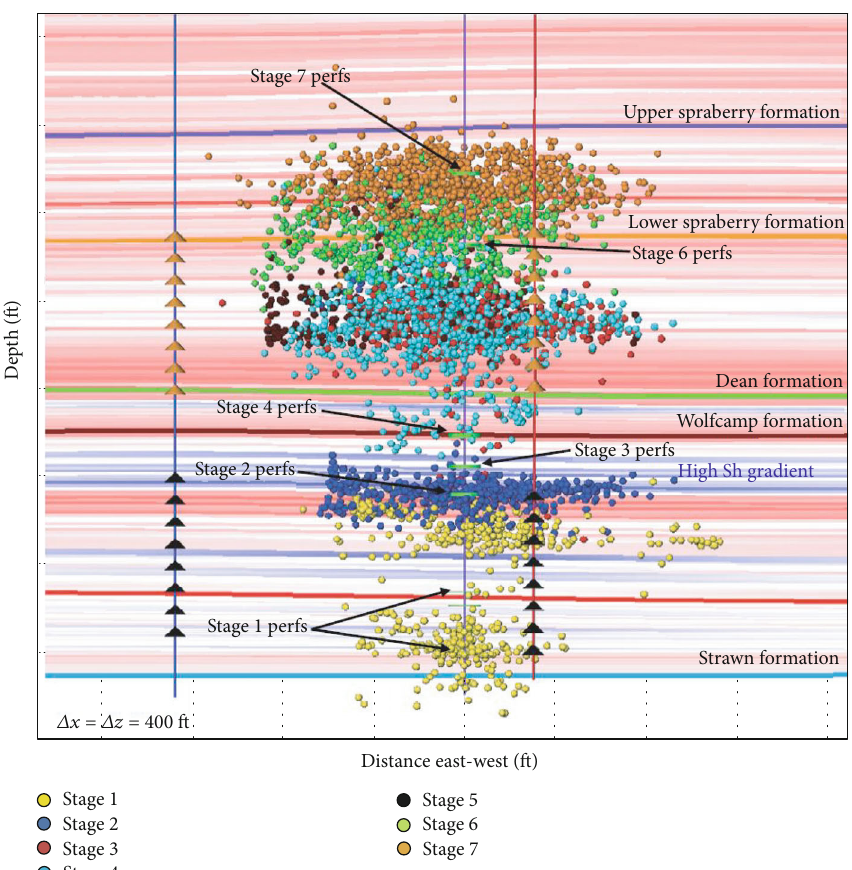
Figure 1: A longitudinal view showing the length and height of the microseismic interpreted hydraulic fractures in di ff erent stages. A cross- section of the minimum horizontal stress gradient is also presented in this fi gure. The dots are observed microseismic events color coded by di ff erent stages. The red, white, and blue colors in the background indicate low, middle, and high minimum stress (Sh) gradients, respectively